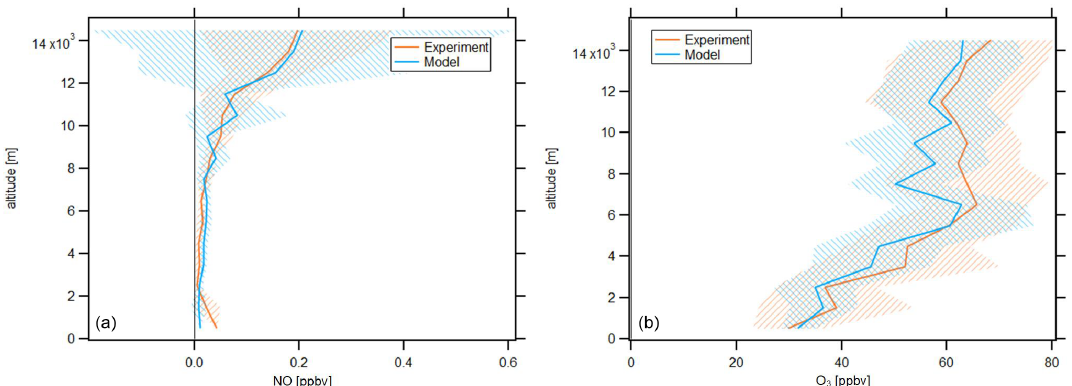
Figure 2. Vertical NO (a) and O 3 profiles (b) of measured and modeled data along the flight tracks during CAFE-Africa. Note the large variability of simulated NO mixing ratios above 10km. The figures have been filtered for stratospheric measurements by removing data points for which O 3 exceeds